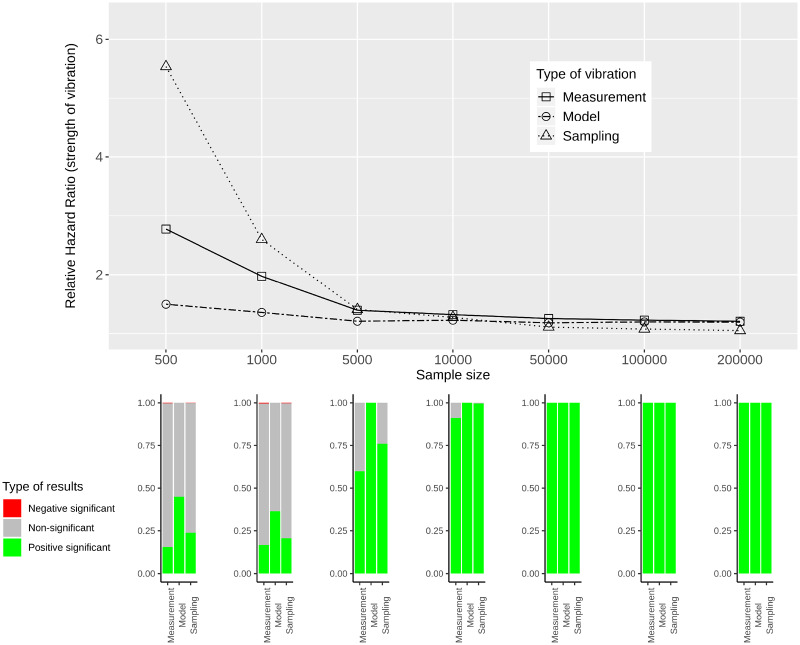
Measurement, model and sampling vibration for different sample sizes (top panel), and bar plots showing the type of results in terms of significance of estimated effects (bottom panel) for the association of diabetes with mortality